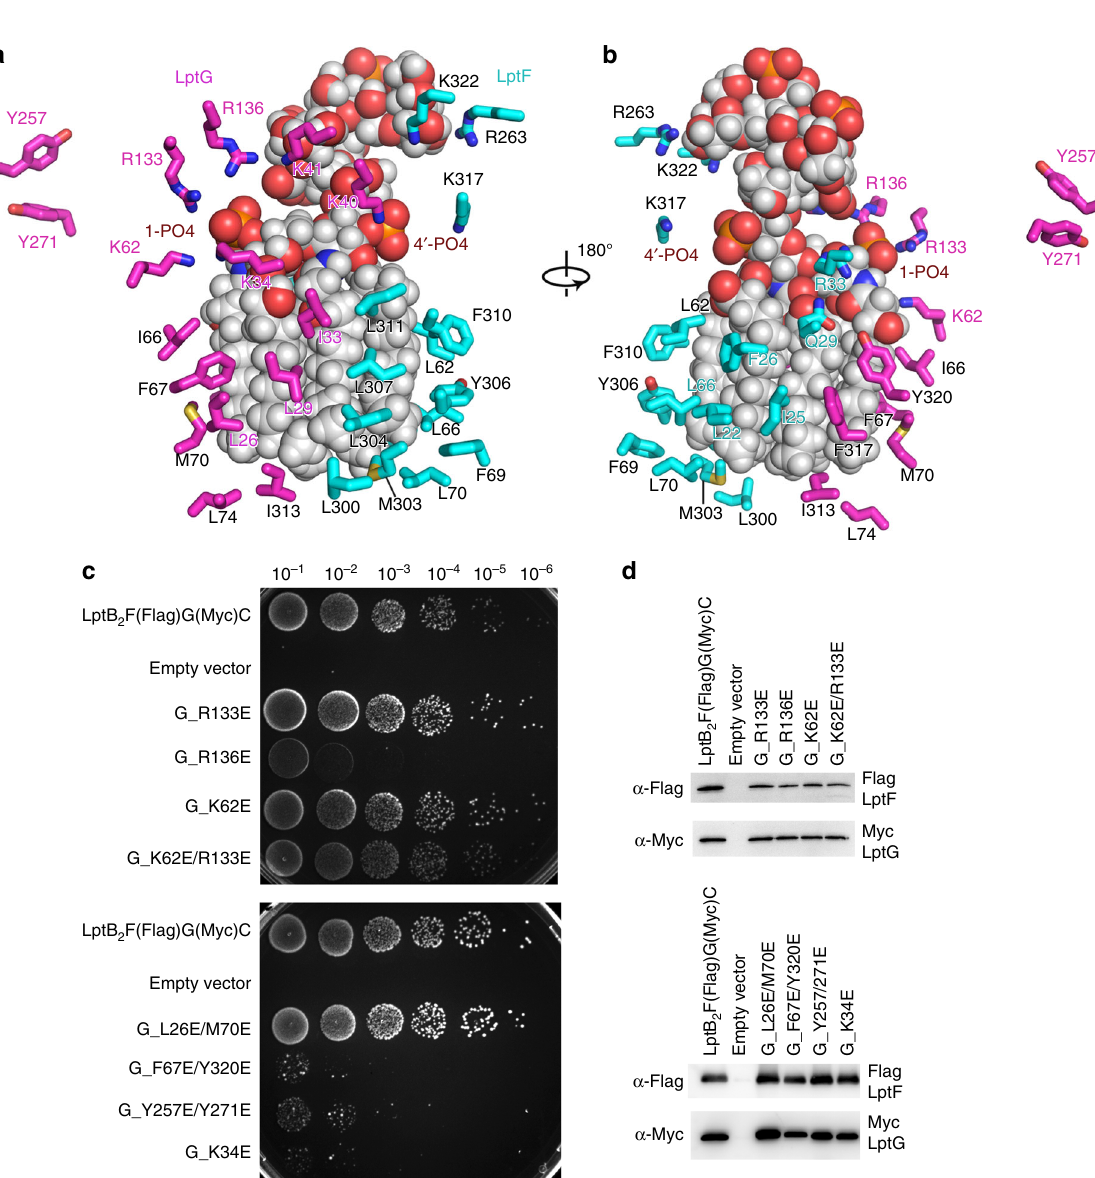
Fig. 2 s f LptB 2 FG recognition of LPS. a Residues of LptF and LptG from the cavity that interact with LPS. LPS is shown in sphere and grey, whereas residues of LptF and LptG are shown in cyan and magenta, respectively. b 180° rotation of a along y -axis. c Functional assays of LptG residues. Mutants R136E, F67E/Y320E, Y257E/Y271E and K34E are lethal, whereas mutants R133E, K62E and L26E/M70E do not affect the bacterial growth. d Expression level of LptF and LptG of the mutants. The western blot showed that the mutant protein expression levels are similar to that of the wild type. Source data for panel d are provided as a Source Data fi